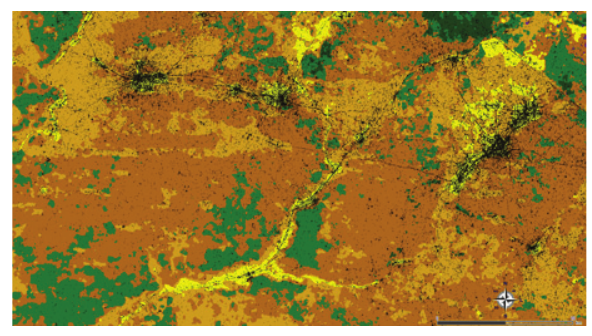
FIGURE 6: Superimposing high-accuracy (< 30 m) lion Global Positioning System locations on the map provides visual indication of good mapping of grassland and bushed grassland